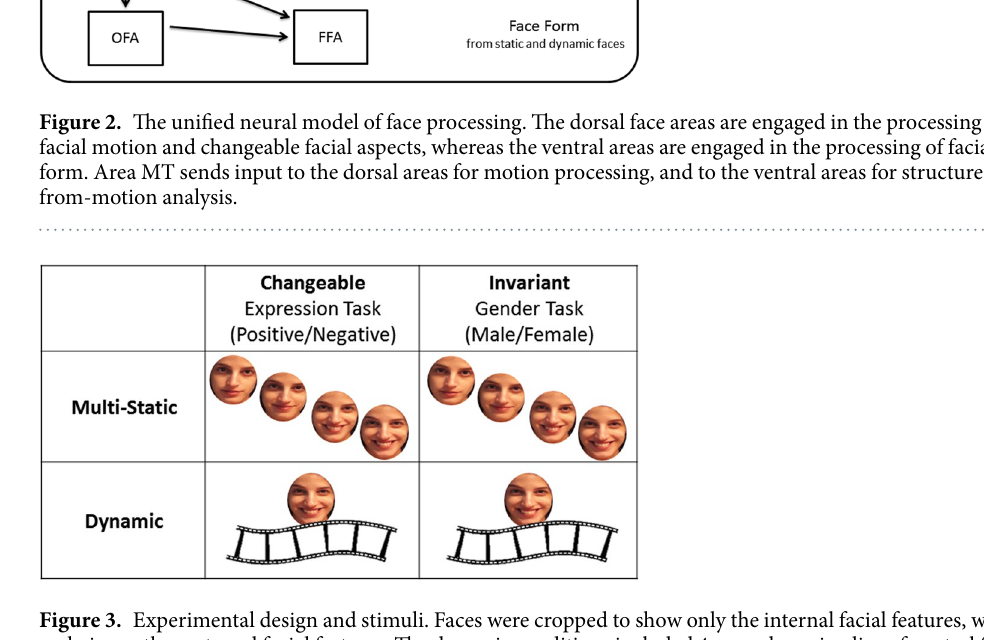
Figure 3. Experimental design and stimuli. Faces were cropped to show only the internal facial features, with no hair or other external facial features. The dynamic conditions included 4 second movie-clips of neutral faces turning happy or disgust. The static conditions included four images from the movie (the first frame of each second) presented for 1 second each in order of appearance in the movie (Version 1) or in a scrambled order (Version